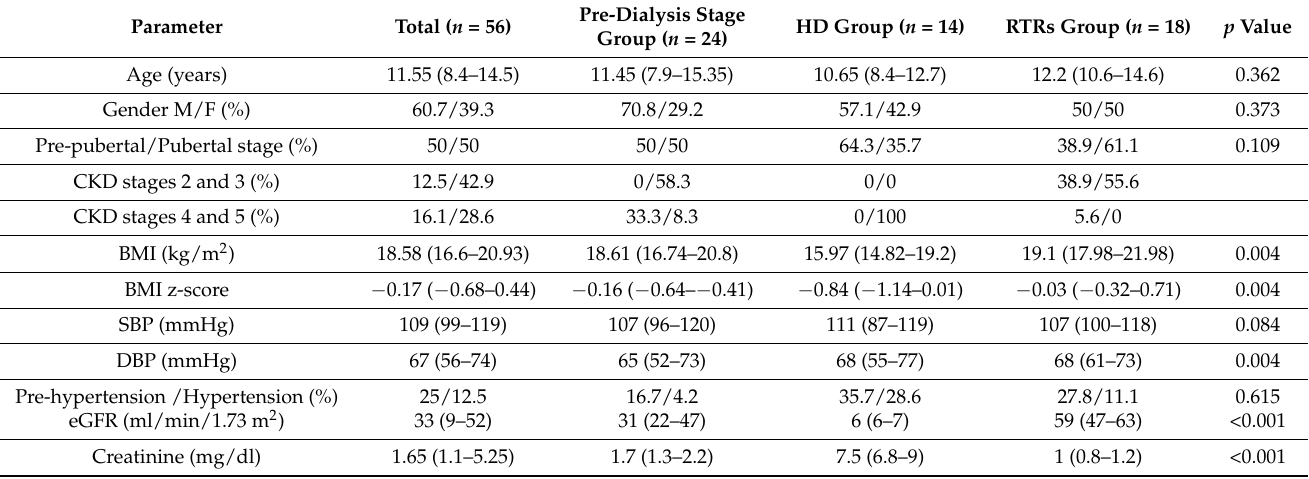
Table 1. Demographic, clinical and laboratory characteristics of CKD patients ( n =